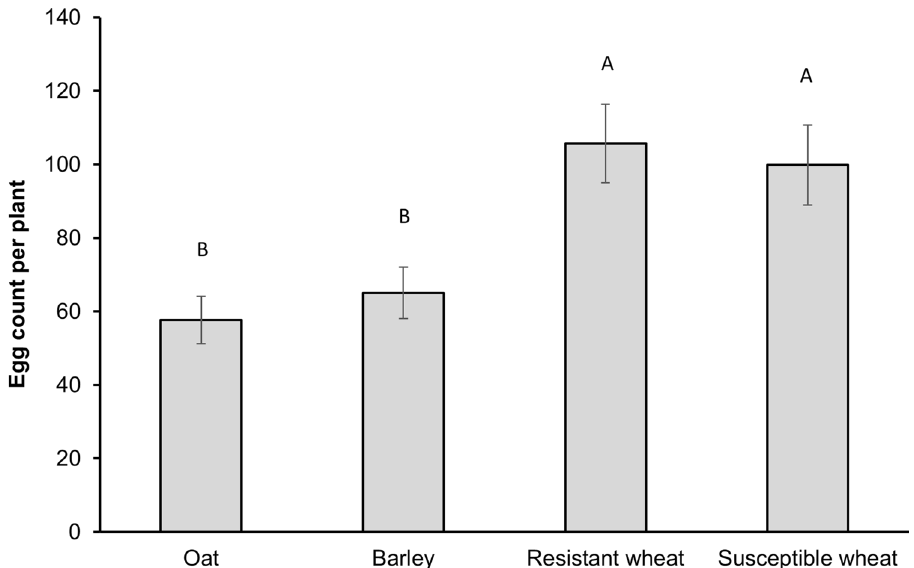
Figure 2. Oviposition (number of eggs per plant) by a single mated female on each host plant treatment in no-choice tests. Error bars represent standard errors (± SE). Oat (cv. Cayuse); Barley (cv. Champion); Resistant wheat (cv. Hollis); Susceptible wheat (cv.